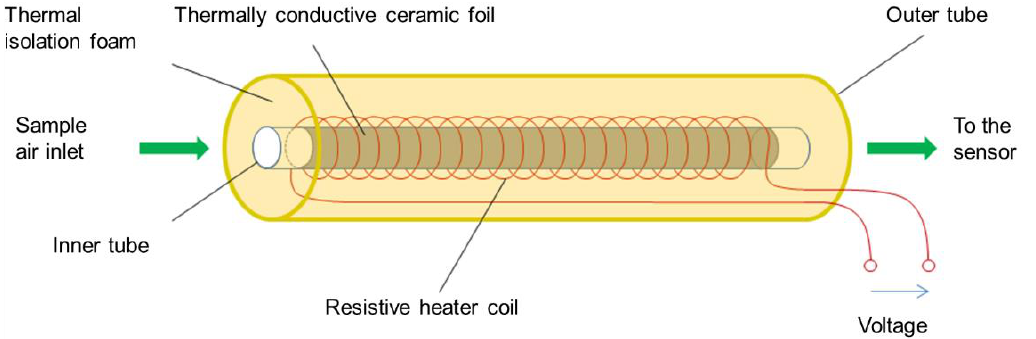
Figure 5. Schematic diagram of the low-cost dryer.